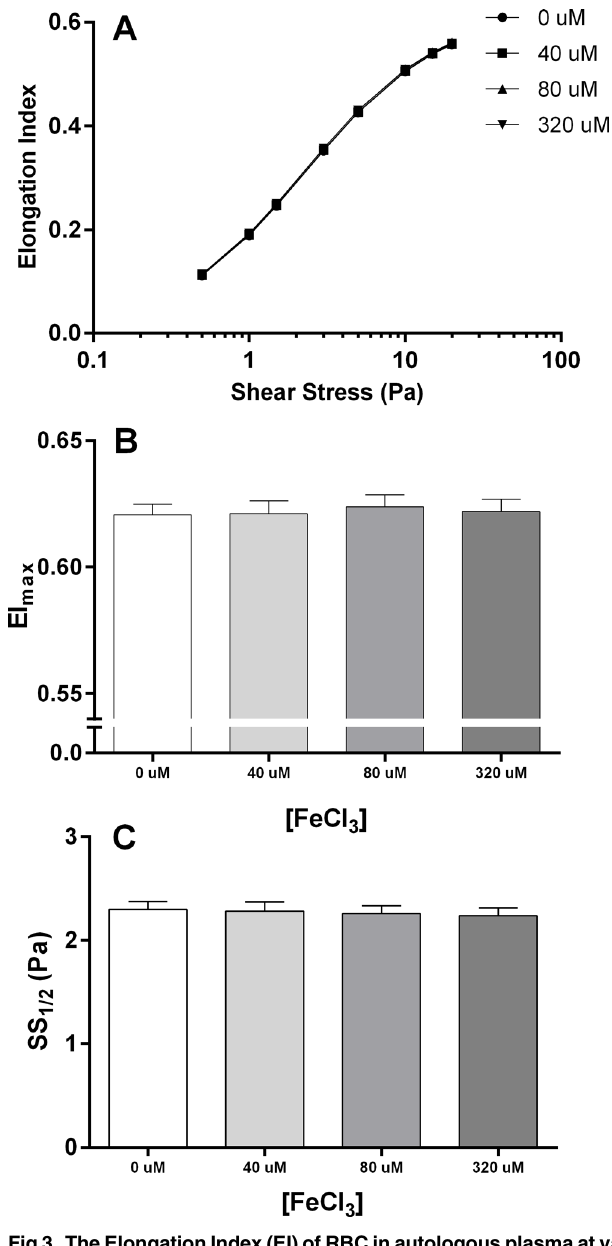
Fig 3. The Elongation Index (EI) of RBC in autologous plasma at varying shear stresses (Panel A) following an incubation with varying concentration of FeCl 3 (0, 40, 80, 320 uM). The varied iron incubated conditions did not influence the maximal EI (EI max ; Panel B) or the amount of shear stress required for half maximal EI (SS half ; Panel